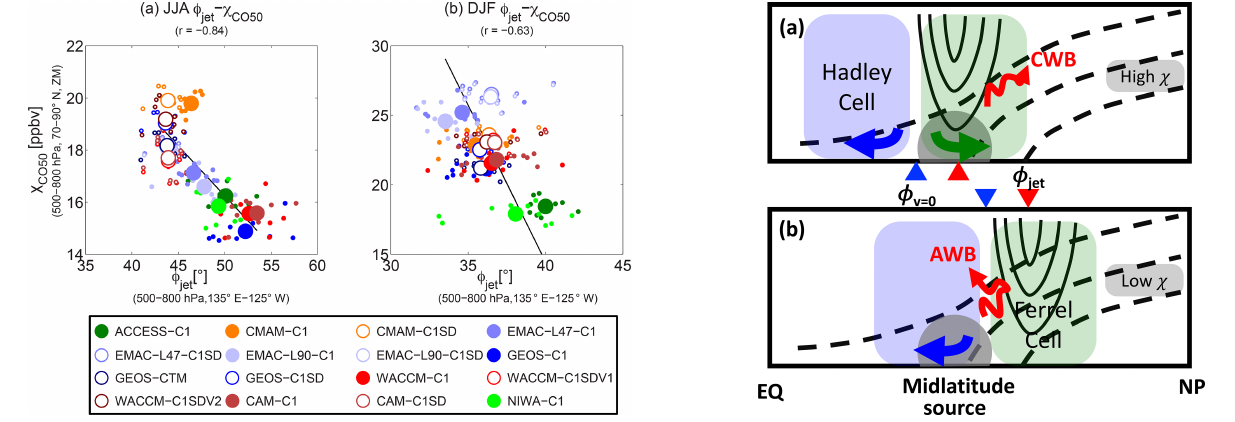
Figure 7. Schematics of mechanisms illustrating dynamic influ- ences on the NH midlatitude-to-Arctic transport for the midlatitude jet situated more southern in (a) and more northern in (b) . When jet location φ jet and meridional flow switching point φ v = 0 are more southern, cyclonic wave breaking (CWB) along the poleward flank of the jet and northward surface meridional flow (green arrow) re- sult in high tracer concentrations in the high latitudes. In contrast, when φ jet and φ v = 0 are more northern, anticyclonic wave break- ing (AWB) along the equatorward flank of the jet and southward surface meridional flow (blue arrow) result in low tracer concentra- tions over the Arctic. Tracer sources in the NH midlatitudes are de- noted by the gray shades, isentropic surfaces are depicted as dashed lines, and red and blue triangles mark the latitude of φ jet and φ v = 0 ,